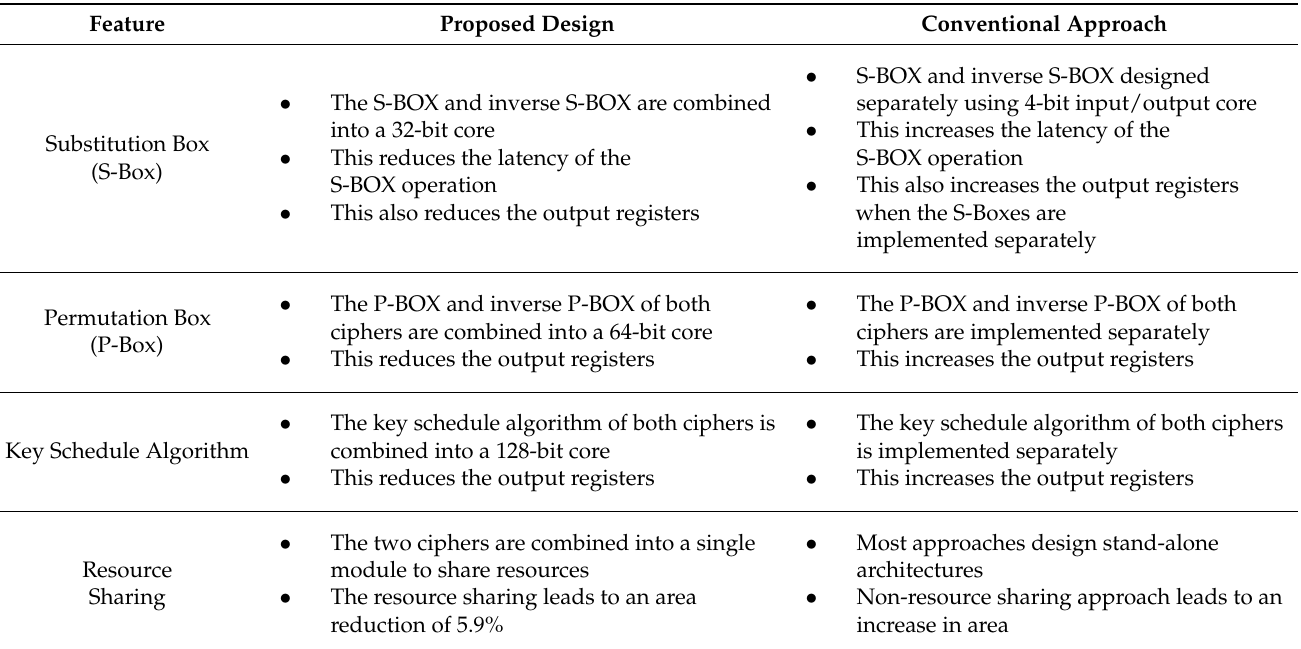
Table 4. Features of the lightweight encryption/decryption unit.